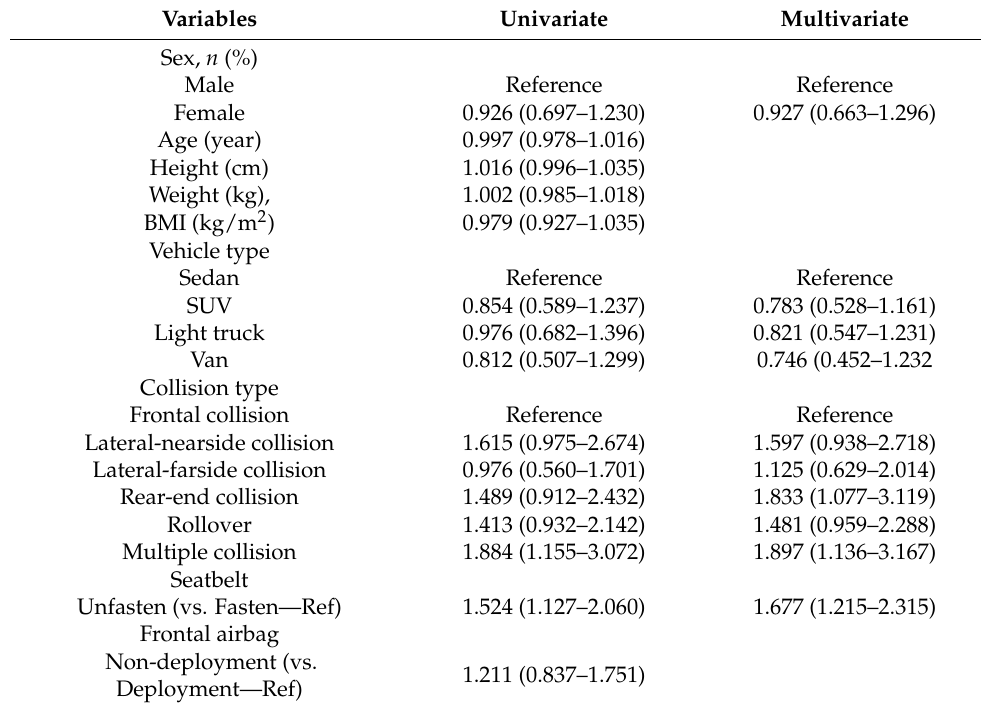
Table 2. Factors affecting the presence of traumatic brain injury (TBI) in the